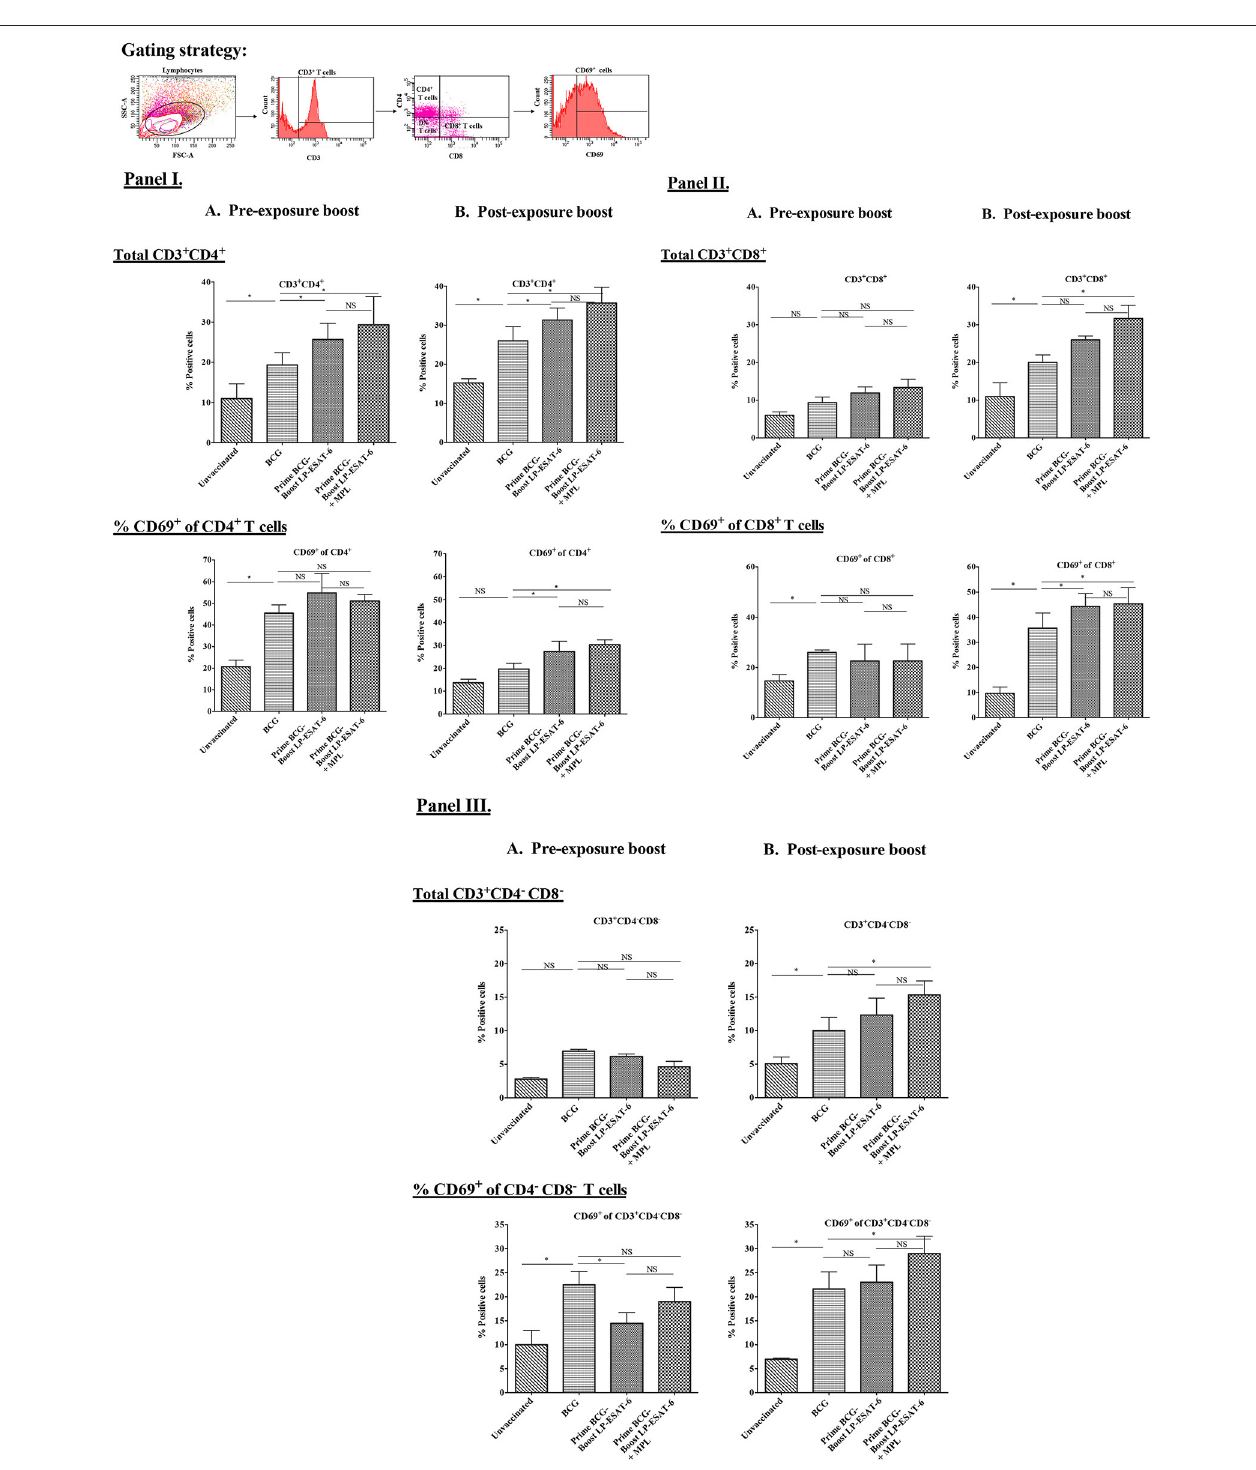
FIGURE 3 | Boosting with LP-ESAT-6 subunit vaccine in BCG-primed mice leads to enhanced recruitment of immune cells in bronchoalveolar lavage fluids. Female BALB/c mice ( n = 5/group) were immunized according to the pre-exposure or post-exposure schedule shown in Figure 1 . Four weeks after infection, mice were euthanized and lung lavages were collected from (A) pre-exposure boost and (B) post-exposure boost groups to examine the presence and activation (CD69 + ) of CD3 + CD4 + (I) , CD3 + CD8 + (II) and CD3 + CD4 − CD8 − (DN) T cells (III) by flow cytometry. The gating strategy shown above the bar graphs in (I) was used to detect the different subsets of T cell based on the expression of CD3, CD4, CD8 and CD69 markers by flow cytometry analysis. Mean ± standard deviations of percent positive cells from five individual mice are shown. *Indicates significant difference (* P < 0.05) between the compared groups and “NS” represents not significant ( P > 0.05). Data are representative of two different repeated